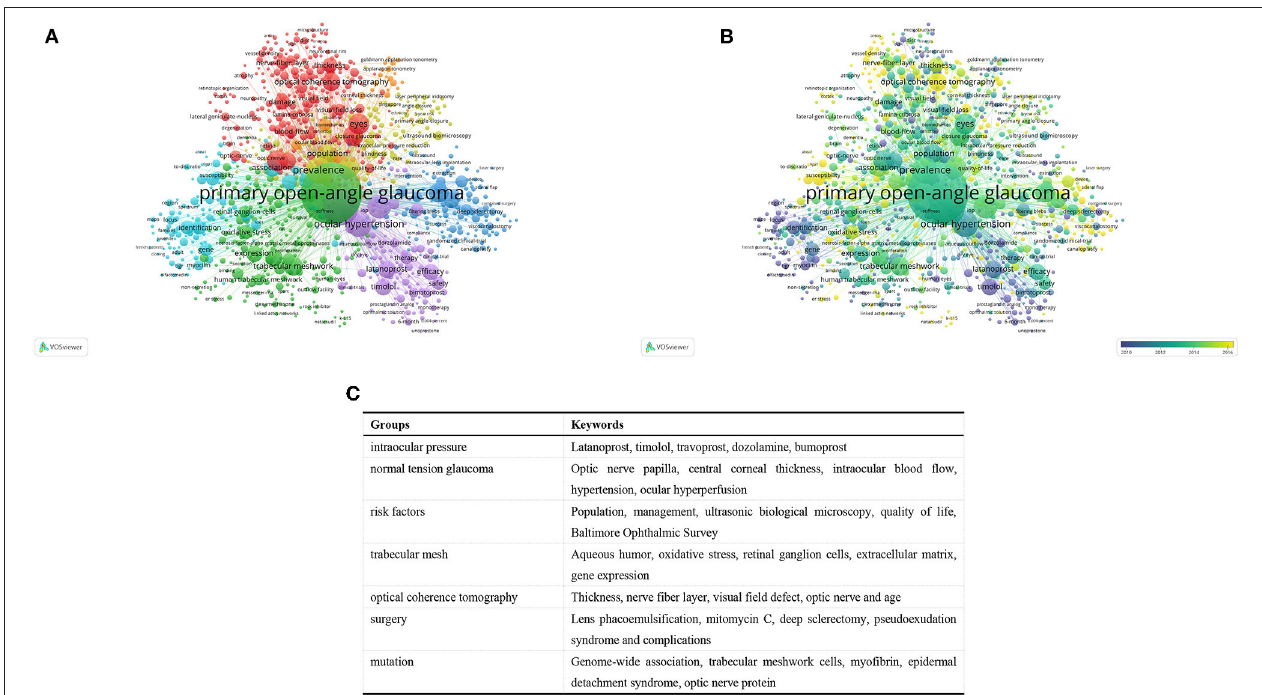
FIGURE 5 | Co-occurrence analysis on POAG research. (A) Network visualization map of keyword co-occurrence analysis using VOS viewer. All keywords are labeled. The size of the node reflects the occurrence frequency of a certain keyword. The larger the size of the node is, the more frequently the keyword co-occurs. VOS viewer marks keywords with different colors, and the color of the nodes and labels indicates the cluster in which they belong to. Closely related keywords are grouped into one cluster with the same color. The higher the quantity of co-occurrences of two keywords, the closer will they be located in the network; (B) Overlay visualization map of keyword co-occurrence analysis. The meanings of the node and label in this map are the same as in Table 6 . However, the color of each node in this map indicates the average year of the keyword in the article according to the color gradient in the lower right.